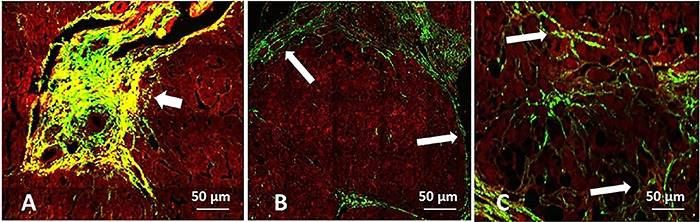
Second harmonic generation and two-photon excited fluorescence images of different patterns of fibrosis by different etiologies. Collagen is stained green and liver cell structure is stained red. A, Primary biliary fibrosis, in which fibrosis began in portal tracts (arrow). B, Chronic hepatitis B, in which expanded portal tracts are linked by fibrous tissue and slender bridge septa are connected to a portal tract and central vein (arrows). C, Non-alcoholic steatohepatitis, showing pericellular fibrosis, fibrous lattice surrounding individual and small groups of hepatocytes and vacuoles cells (arrows).